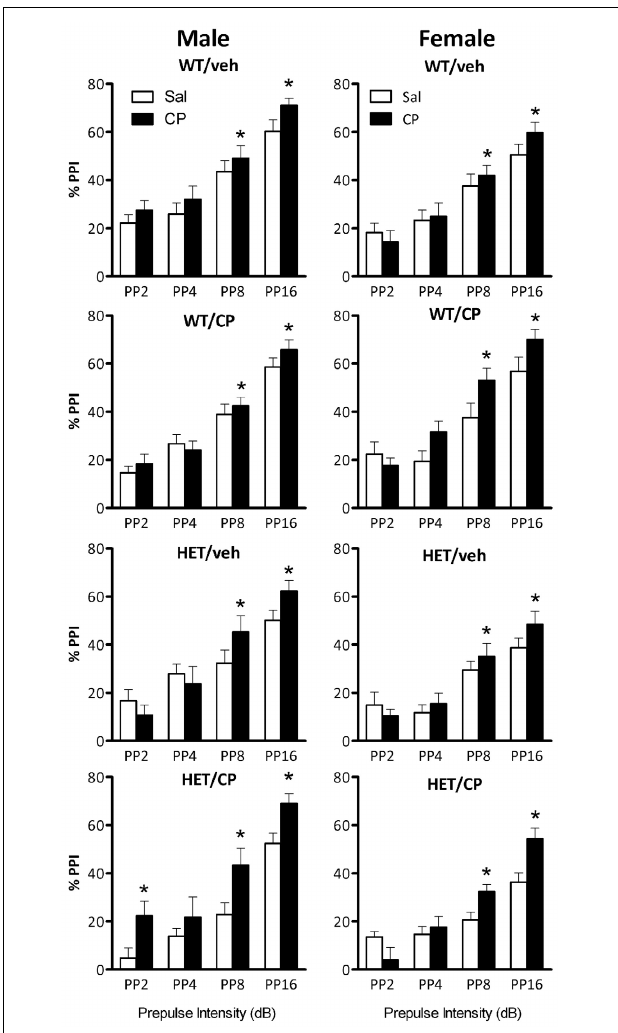
FIGURE 5 | Percentage prepulse inhibition (PPI) expressed per prepulse intensity in the four treatment groups: WT/veh, WT/CP, HET/veh, and HET/CP in both sexes. All groups were administered saline (Sal; open bars) or 0.4mg/kg CP55,940 (CP; black bars) PP2, PP4, PP8, and PP16 indicate prepulse intensities of 2, 4, 8, and 16dB over the 70dB background with a 100ms interstimulus interval. Data are mean ± SEM. ∗ P < 0 . 05 for difference with acute saline treatment based on ANOVA main effect (PP8 and PP16) or CP × genotype × pre-treatment interaction and pair-wise comparison (PP2).